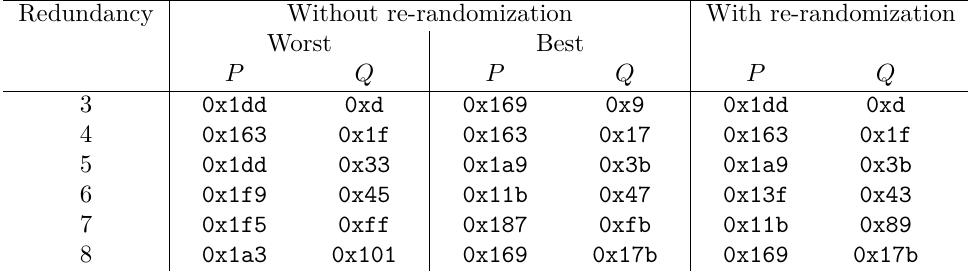
Table 1: Polynomial pairs used for the first order TVLA